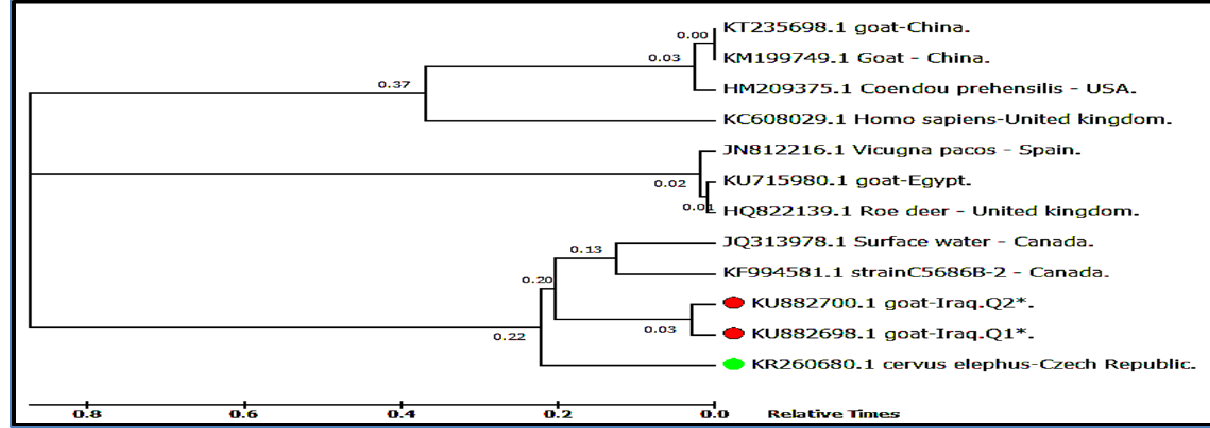
Figure, 7: Phylogenetic tree depend on the Neighbor joining tree method. The phylogenetic distances analyses were conducted by MEGA6. *Red spot: C. ubiquitum strains isolated from Iraq.*Green spot: Strain high homologous with Iraqi – C. ubiquitum isolated from goat 1*, 2*.